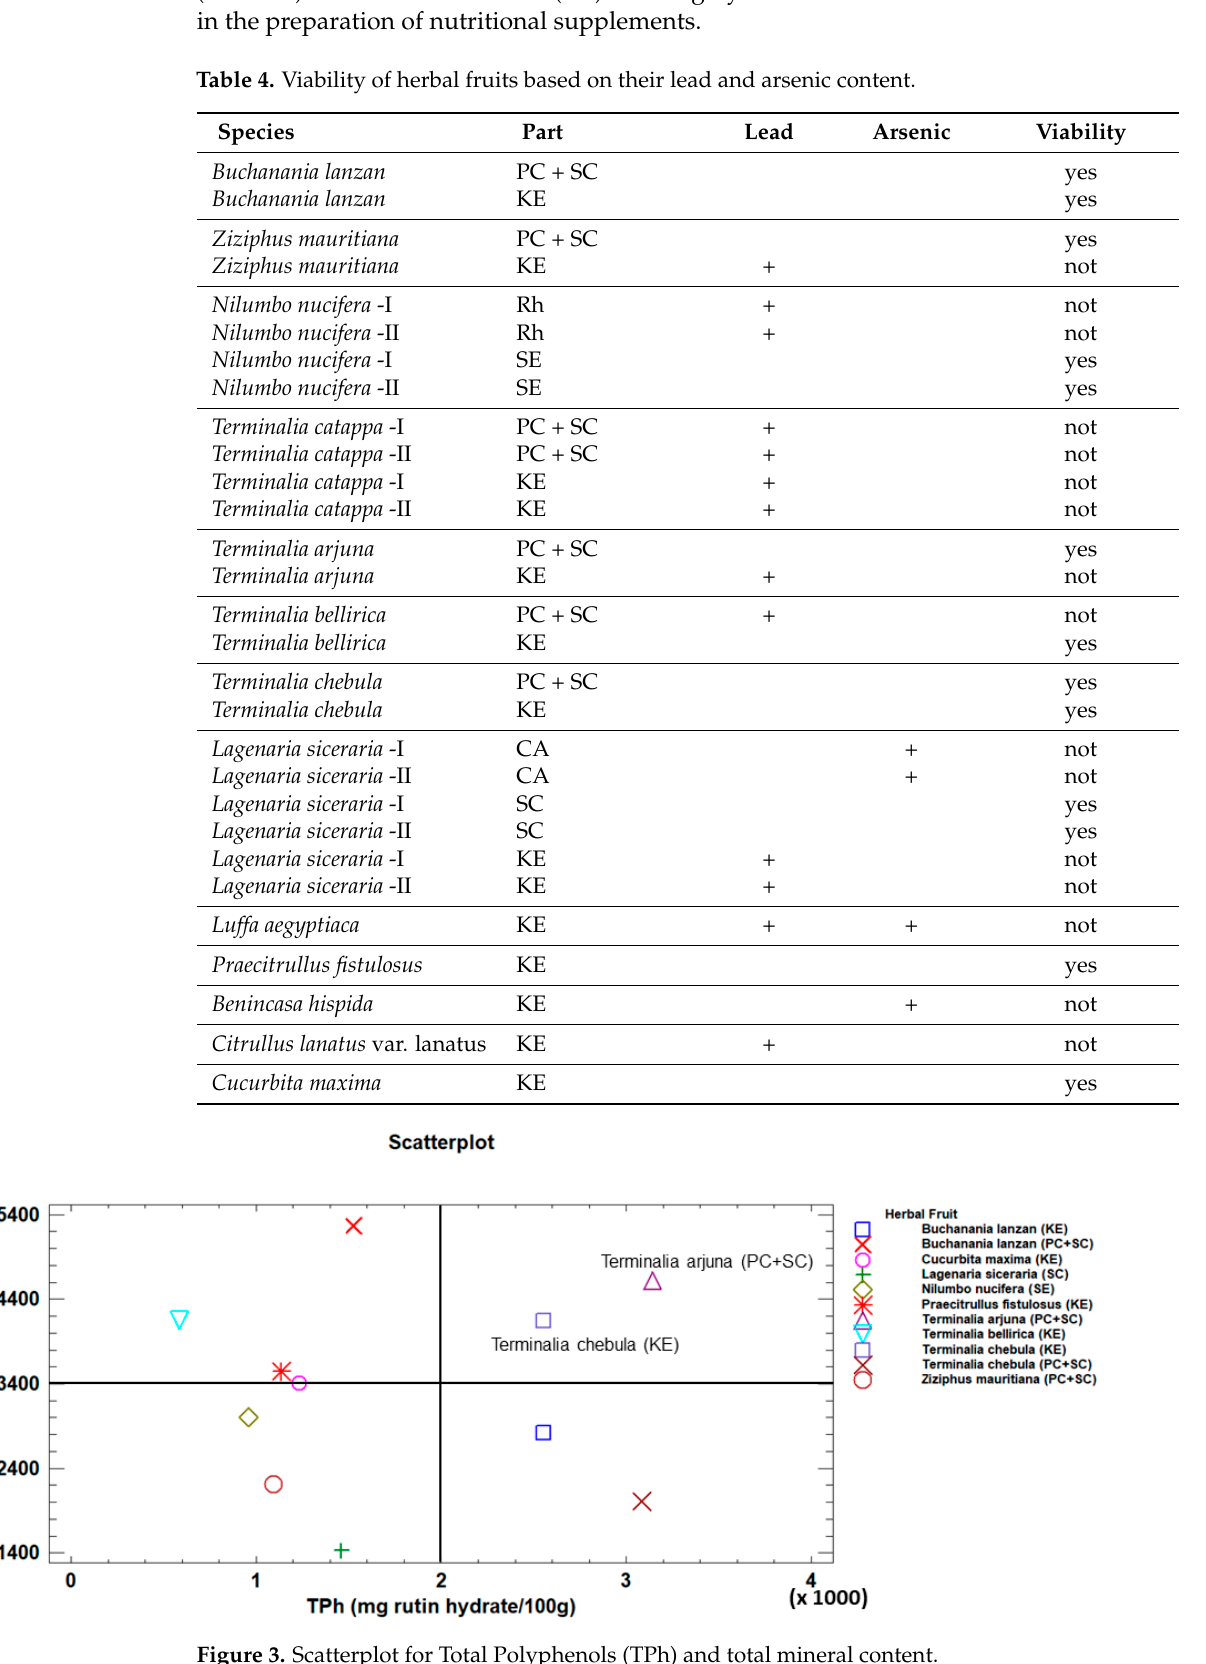
Figure 3. Scatterplot for Total Polyphenols (TPh) and total mineral content.